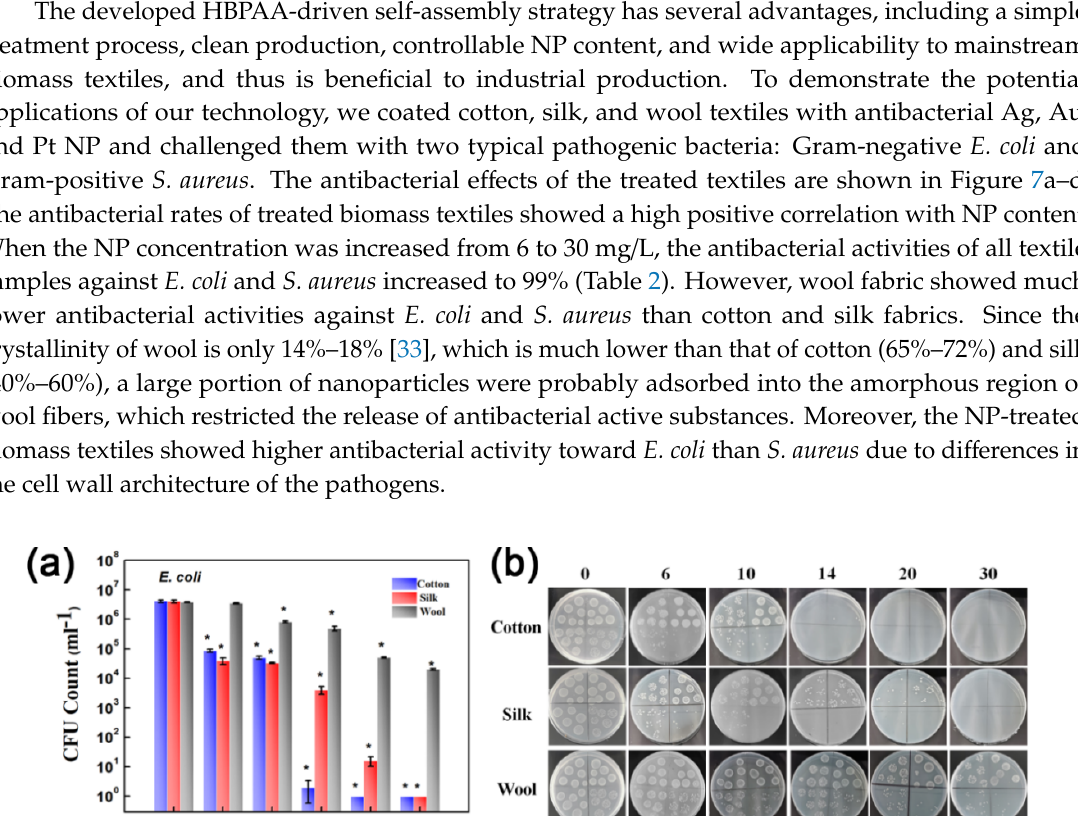
Table 2. Antibacterial rates of as-prepared Ag, Au, and Pt NP-coated cotton, silk, and wool textiles. NP concentration